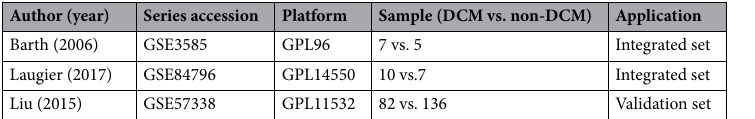
Table1. The characteristic baseline of DCM gene expression profiles. DCM: dilated cardiomyopathy.